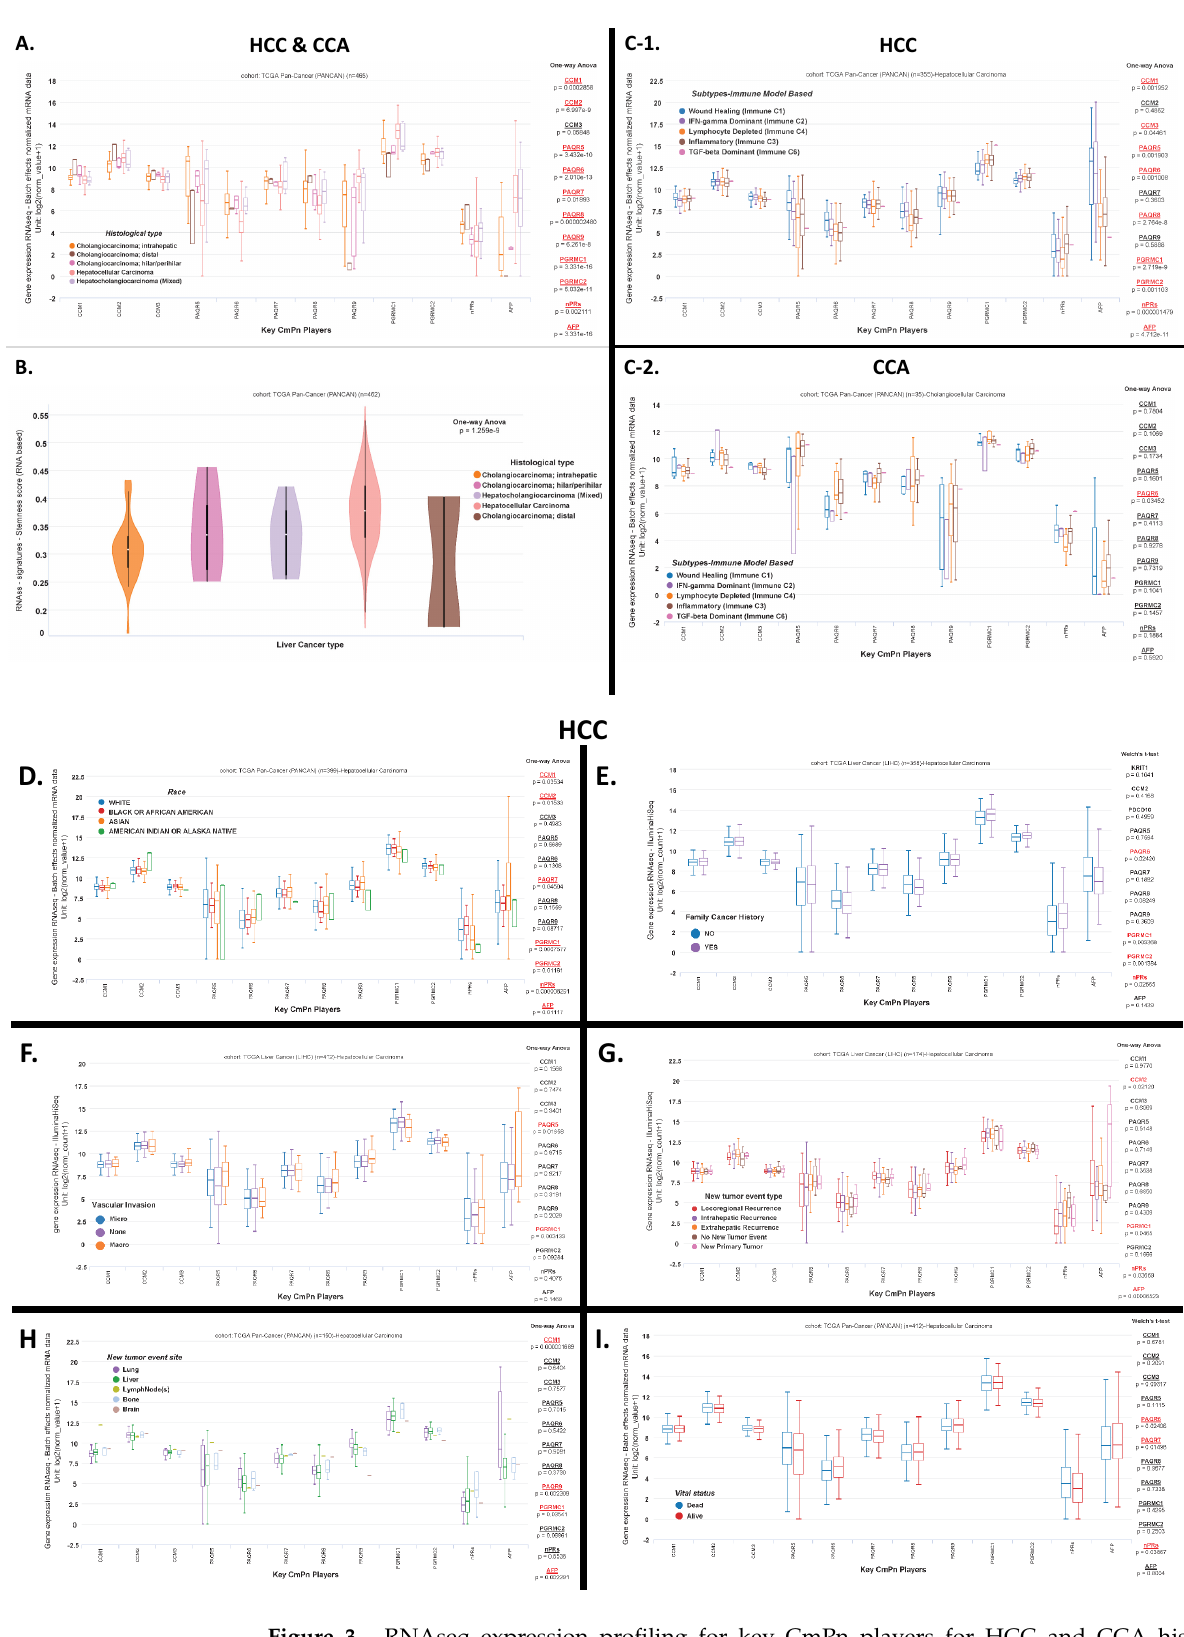
Figure 3. RNAseq expression profiling for key CmPn players for HCC and CCA histologi- cal/immunological subtypes integrating SES and follow-up clinical data. We investigated key CSC , mPR , and nPR players expression analysis, along with AFP , between histological and immunological subtypes (panels A , C1 , C2 ) and assessed stemness scores (panel B ) between major HCC and